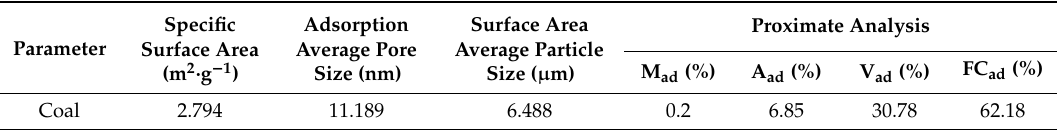
Table 1. 1 / 3 Coking coal characteristics